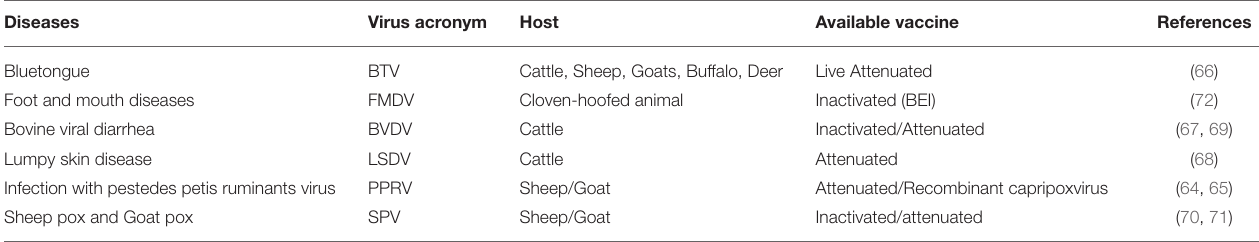
TABLE 1 | OIE’s notifiable disease and licensed